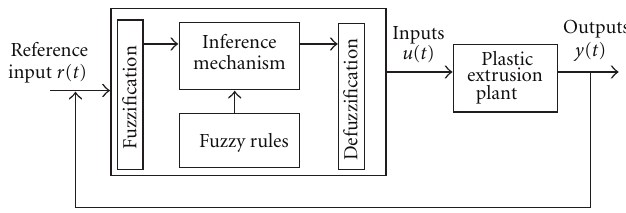
Figure 4: FLC controller-based plastic extrusion system.